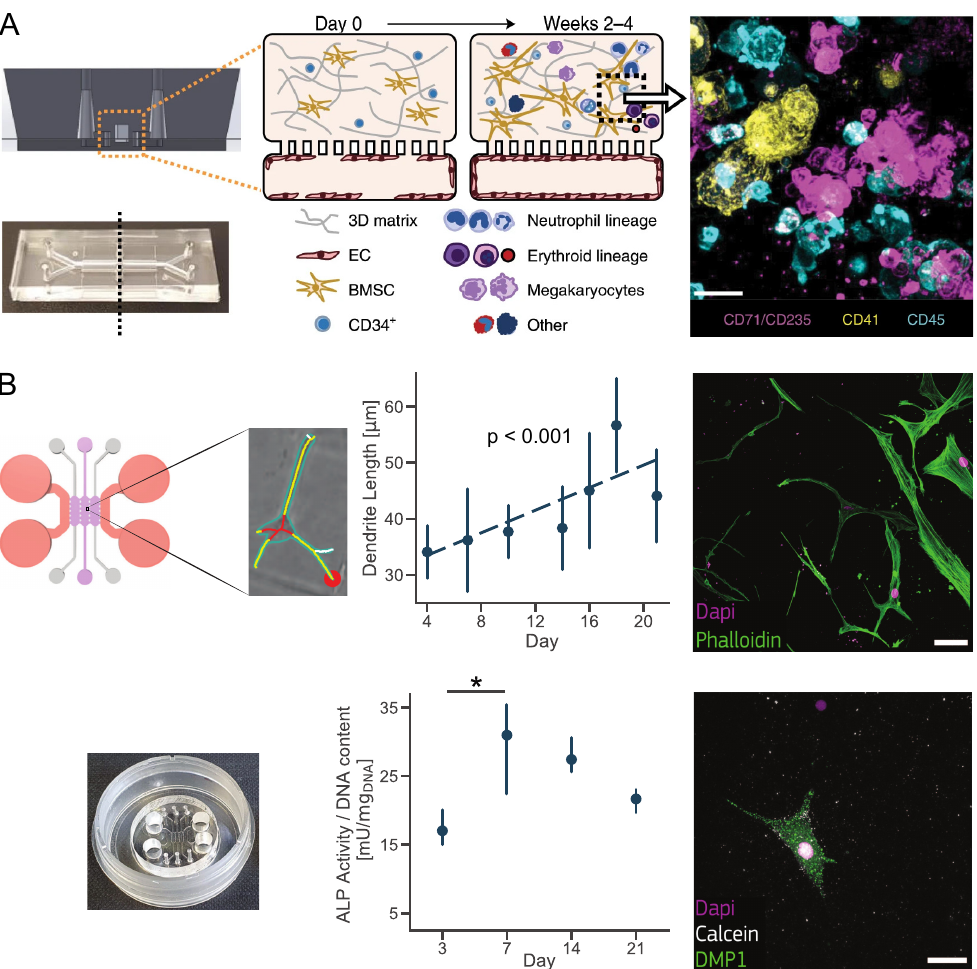
Figure 3. Inducing cell differentiation in hydrogel-based bone-on-chips. ( A ) A vascularized human bone marrow-on-chip was developed with optically clear poly(dimethylsiloxane) channels. In the top channel, hematopoietic stem cells (CD34 + ) were seeded, while endothelial cells (EC) created a vascular lumen in the bottom channel. After 2 weeks of in vitro culture, hematopoietic stem cells differentiated in multiple blood cell types (magenta: erythroid lineage; yellow: megakaryocyte lin- eage; blue: neutrophil and other haematopoietic lineages). Scale bar, 20 µm. Image adapted from [16]. ( B ) Collagen-based bone-on-chip modeling primary human osteoblast differentiation into osteo- cytes. Cells increased primary protrusion length over time and exhibited dendritic morphology after 21 days of culture. Osteogenic differentiation was confirmed by an increasein alkaline phosphatase activity and synthesis of Dental Matrix Protein 1 (DMP1). * represents statistical significance ( p < 0.05). Scale bar, 50 µm. Image adapted from [88]. Images were taken with permission from